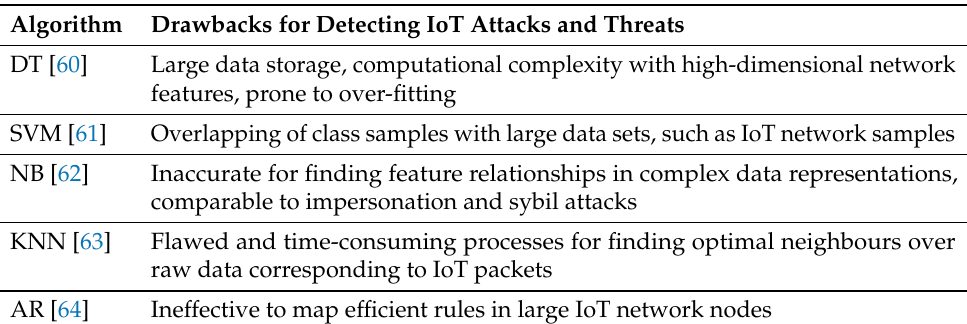
Table 8. Comparison of different shallow algorithms and detected flaws.